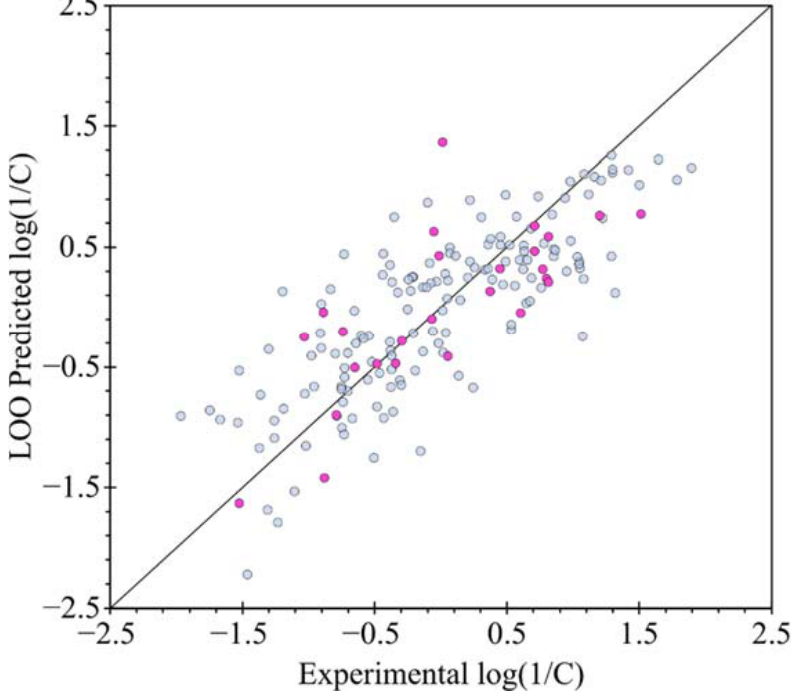
Figure 5. Graph of predicted LOO values of log(1/C) vs. experimental values of log(1/C) for training set (light blue dots) and for test set (violet dots), solid line is a diagonal plot.